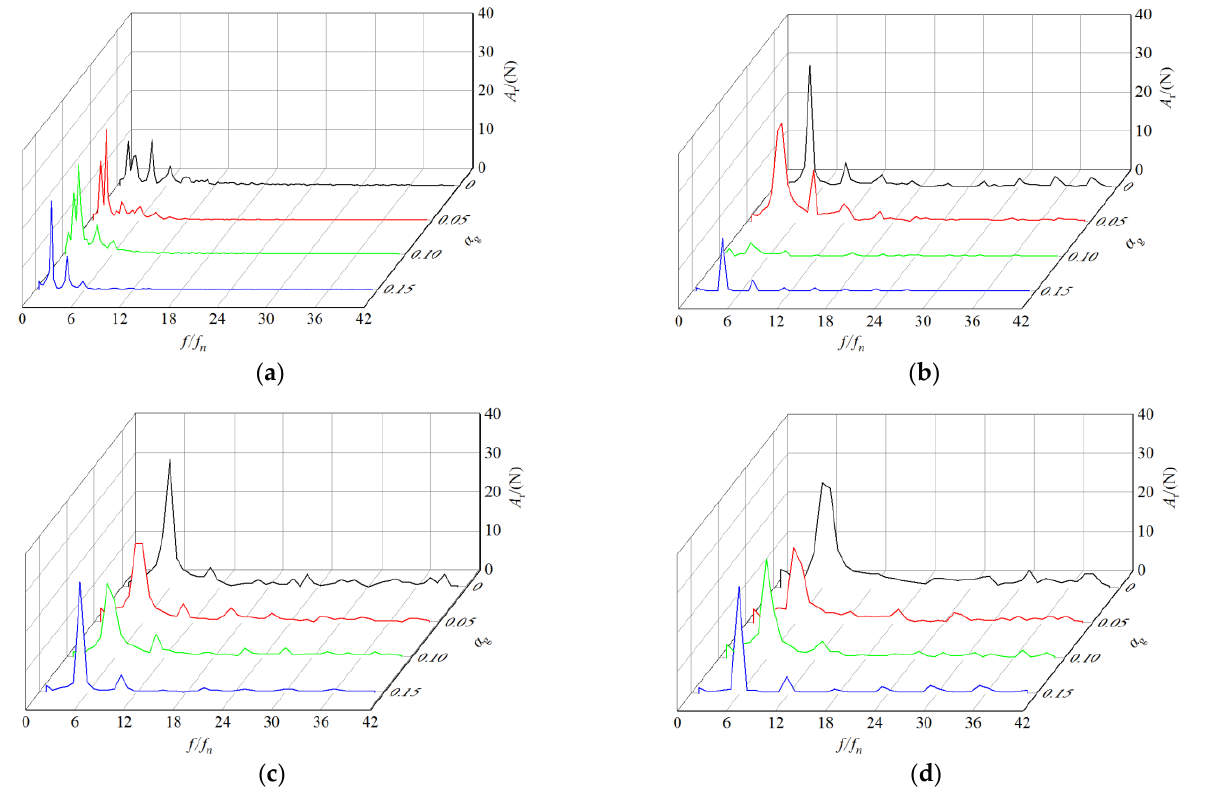
Figure 13. Frequency domain characteristic of radial force pulsation during the start-up process. ( a ) t = 1 s; ( b ) t = 2 s; ( c ) t = 3 s; ( d ) t = 4 s.